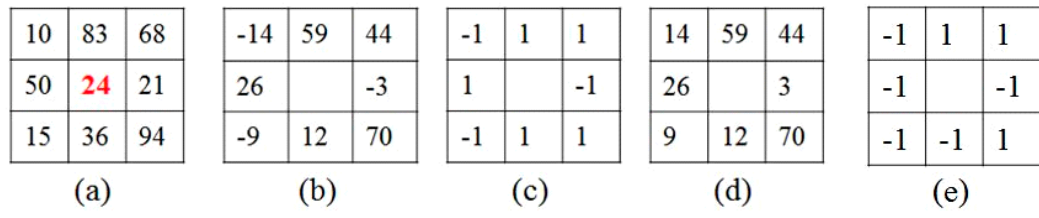
Figure 1. ( a ) 3 × 3 sample block; ( b ) the local differences; ( c ) the sign component of CLBP; ( d ) the absolute value of local differences; ( e ) the magnitude component of CLBP.